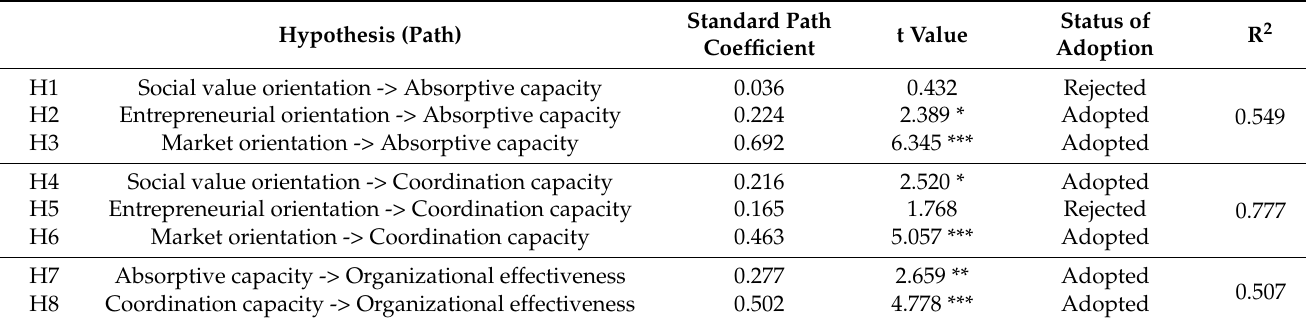
Table 5. Results of hypothesis test.